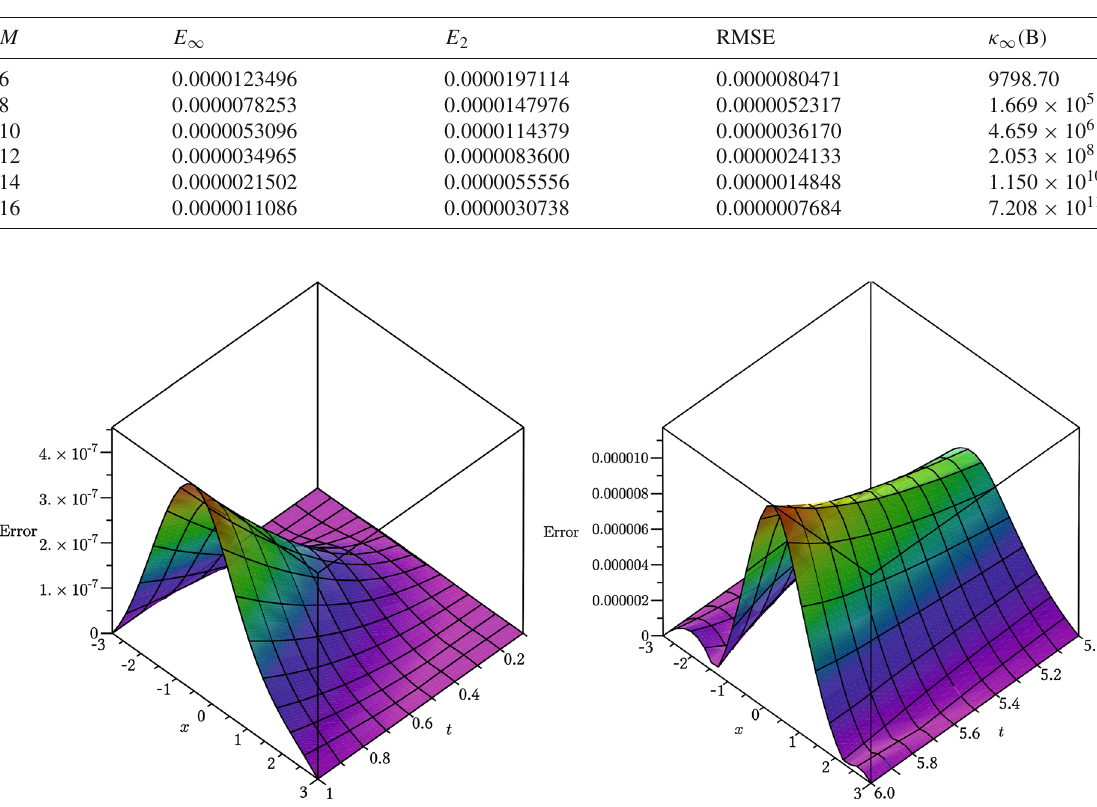
Table 8 The errors and condition number of matrix B of Example 2 with IMQ-RBFs, c = 1 . 65, τ = 0 . 05, α = 0 . 6 for t = 1 and [ a , b ] = [− 1 , 1 ]